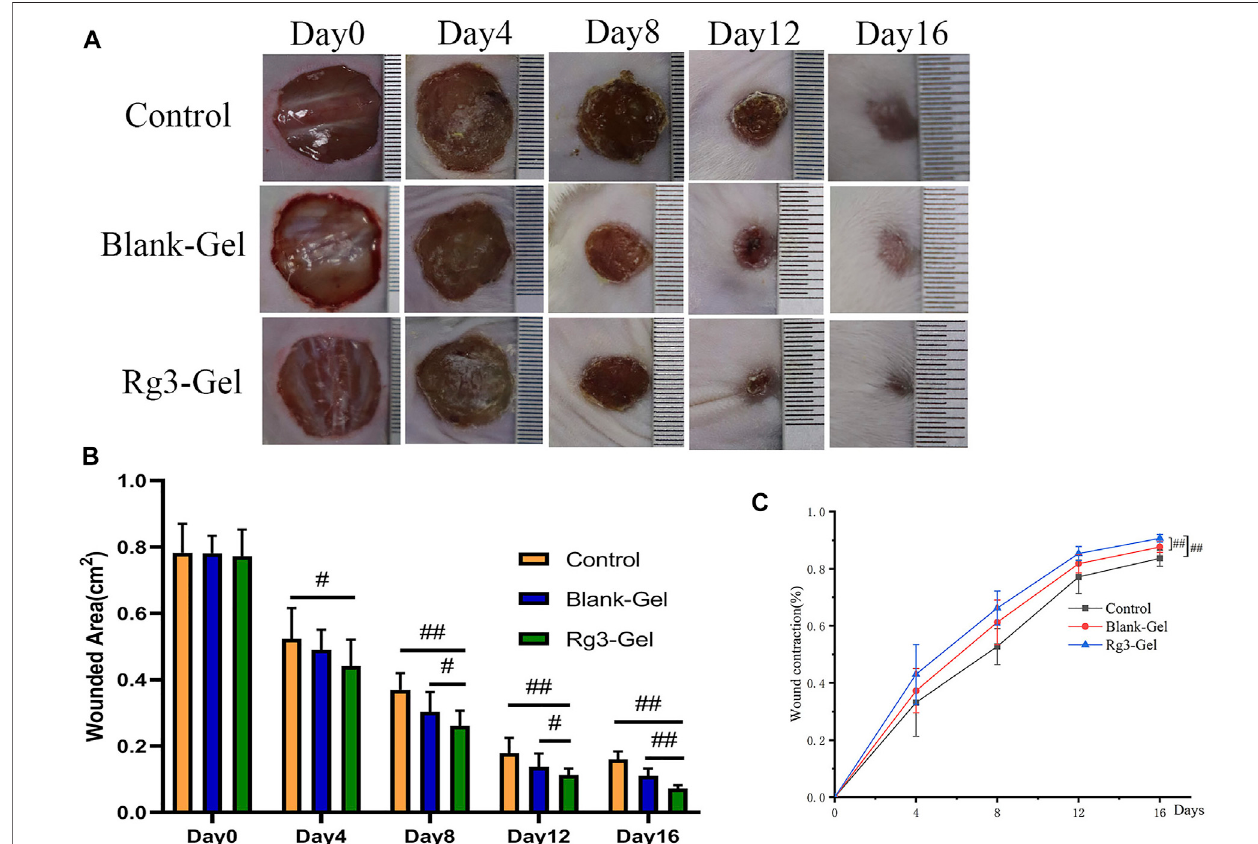
FIGURE4| Invivo woundhealingeffectofRg3-loadedRg3-Gelonfull-thicknessexcisionwoundmodel. (A) Woundsphotographsat0,4,8,12,and16 dayspost- injuryinControl,Blank-Gel,andRg3-Gelgroup.Thescalebarindicates10 mm. (B) Quanti fi cationanalysisofwoundareasat0,4,8,12,and16dayspost-injuryineach group (# p < 0.05, ## p < 0.01, and n = 12). (C) Wound closure represented as the percentage of reduction of the initial area in each group during post-injury 14 days. Control, Blank-Gel, and Rg3-Gel represent the Control group, the blank hydrogel group, and the Rg3 hydrogel group, respectively (# p < 0.05, ## p < 0.01, and n =